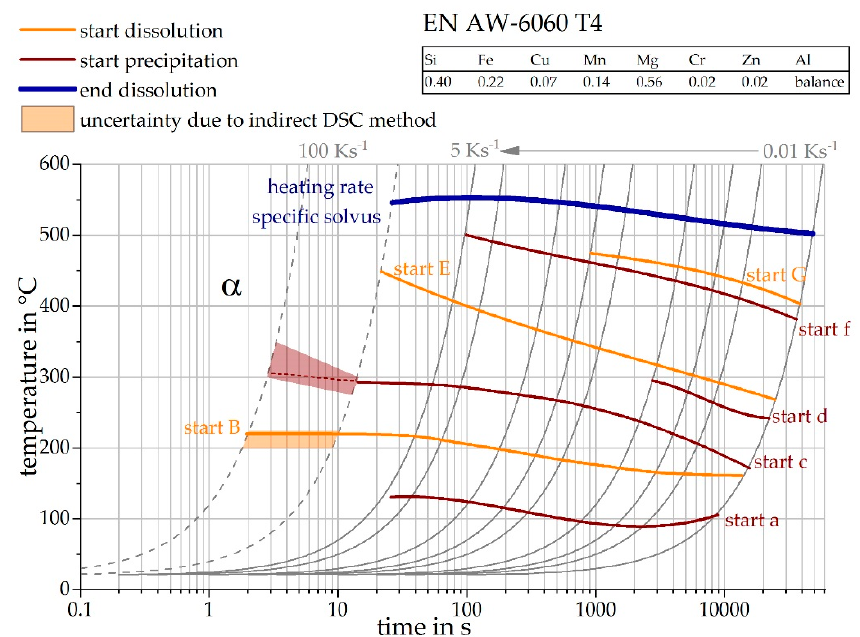
Figure 16. Continuous heating dissolution diagram of EN AW-6060 T4, including the findings of the indirect measurements.